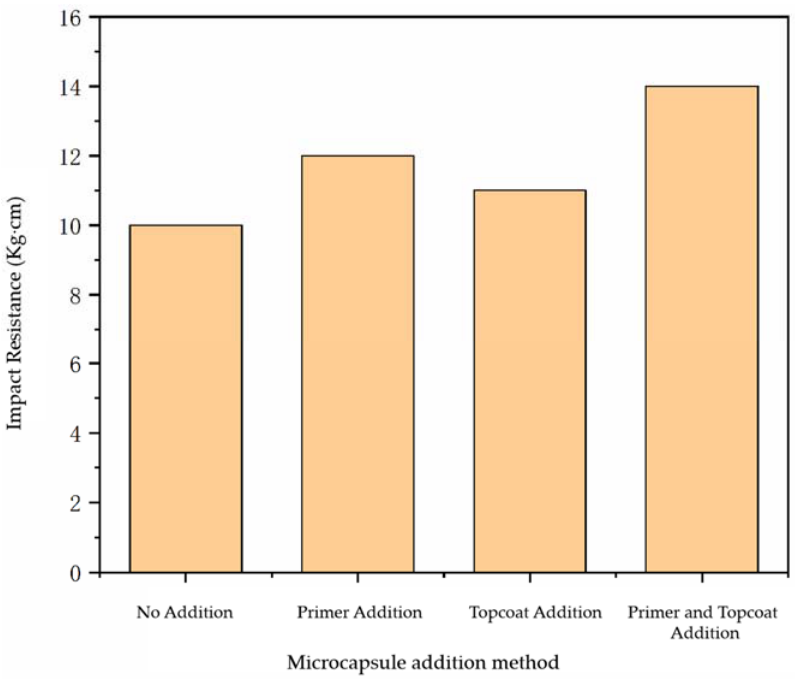
Figure 3. Influence of adding methods on the impact resistance of paint film.